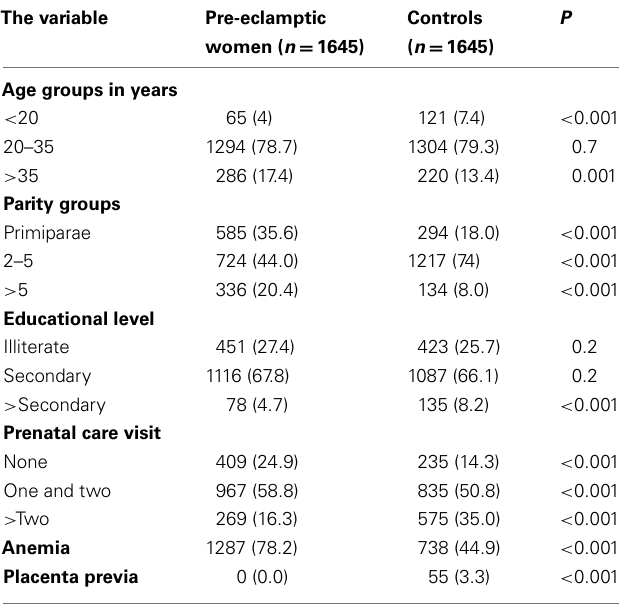
Table 1 | Comparing age, parity, educational levels, prenatal care, anemia, and placenta previa between the cases and controls.